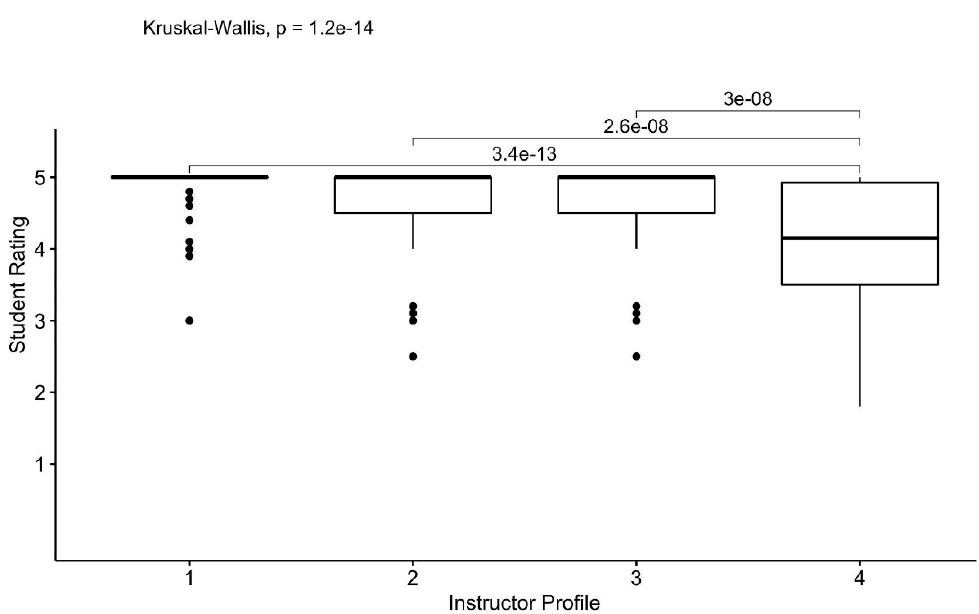
Figure 3. Grammatical Knowledge ratings according to instructor profile. Instructor 1 is a native speaker from Spain, Instructor 2 is a native speaker from Latin America, Instructor 3 is a Heritage Speaker of Spanish, and Instructor 4 is an L2 Spanish speaker.